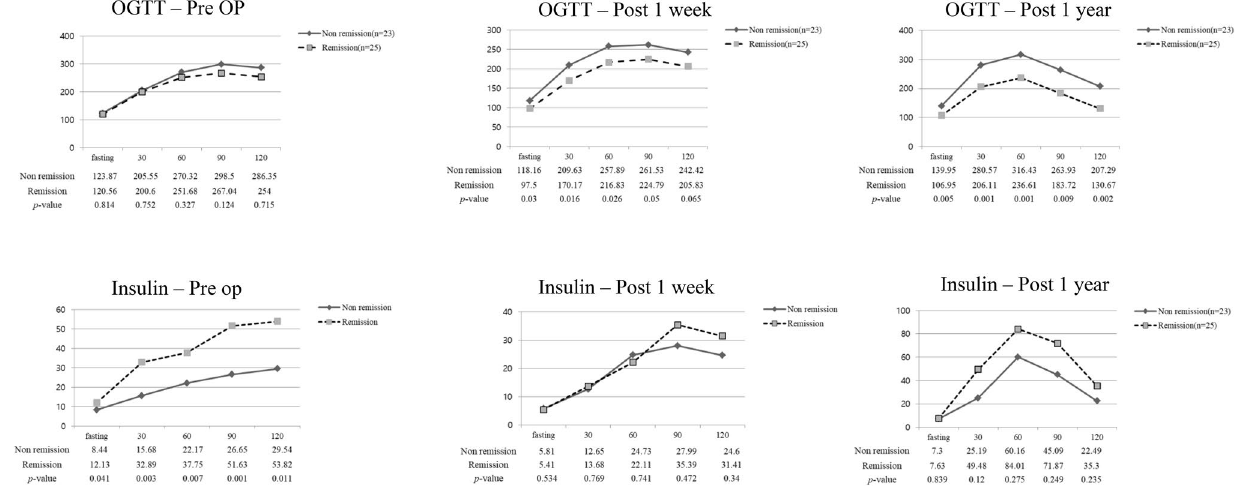
Figure 2. OGTT and serum insulin levels in long-limb Roux-en-Y gastrectomy patients (n = 48).